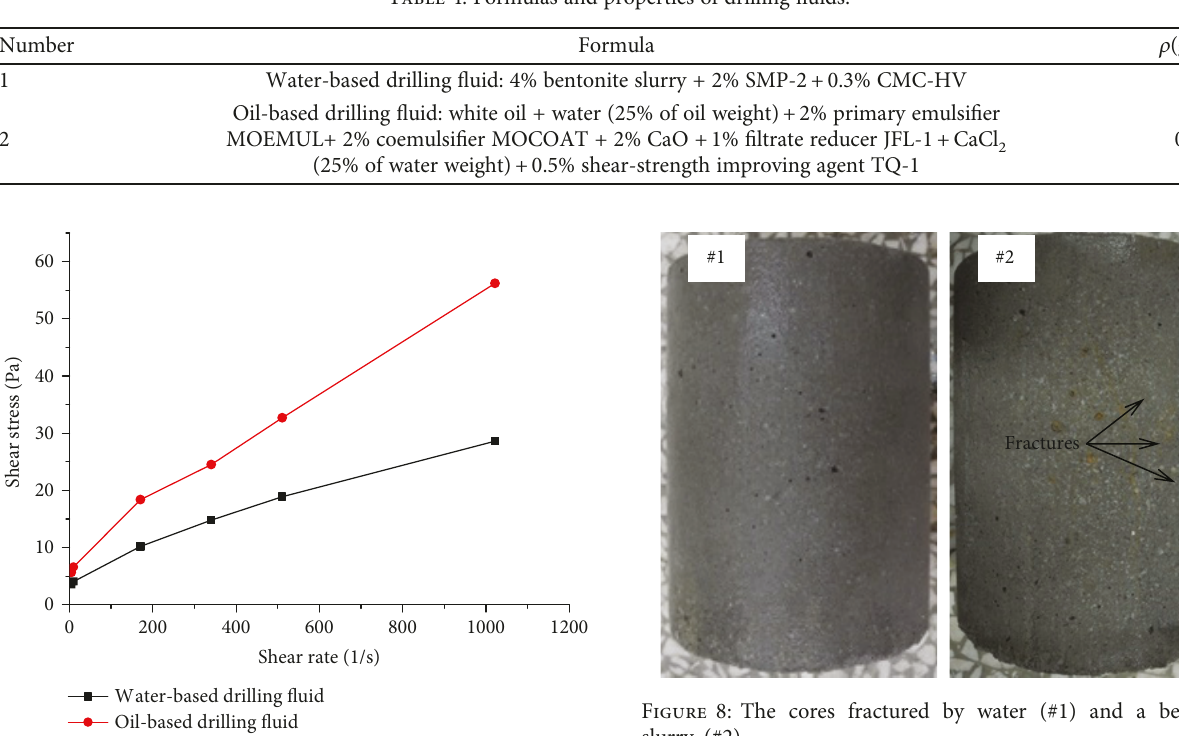
Table 4: Formulas and properties of drilling fl uids.